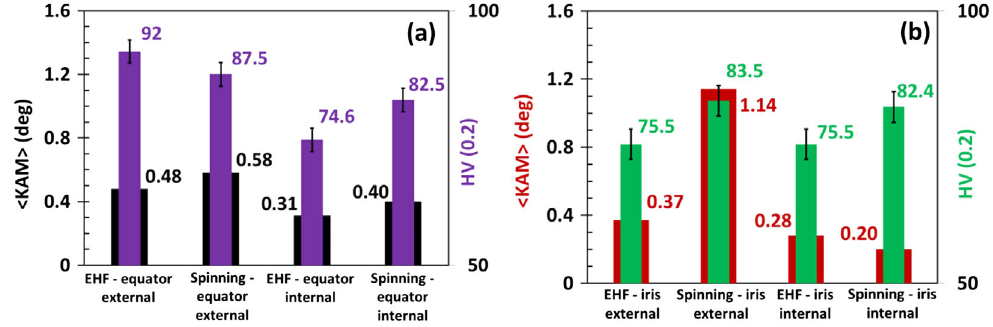
FIG. 21. Weighted average KAM ( h KAM i ) and average hardness values measured in the first 200 μ m close to the external and internal surfaces: (a) specimens extracted from equator; (b) specimens extracted from